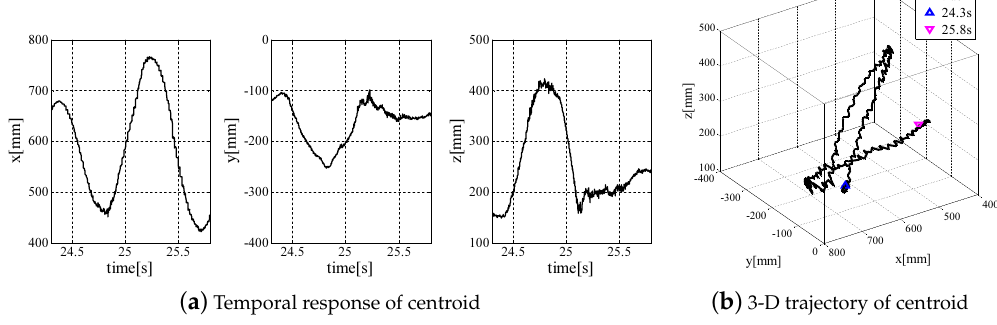
Figure 10. Temporal response of centroid [8].